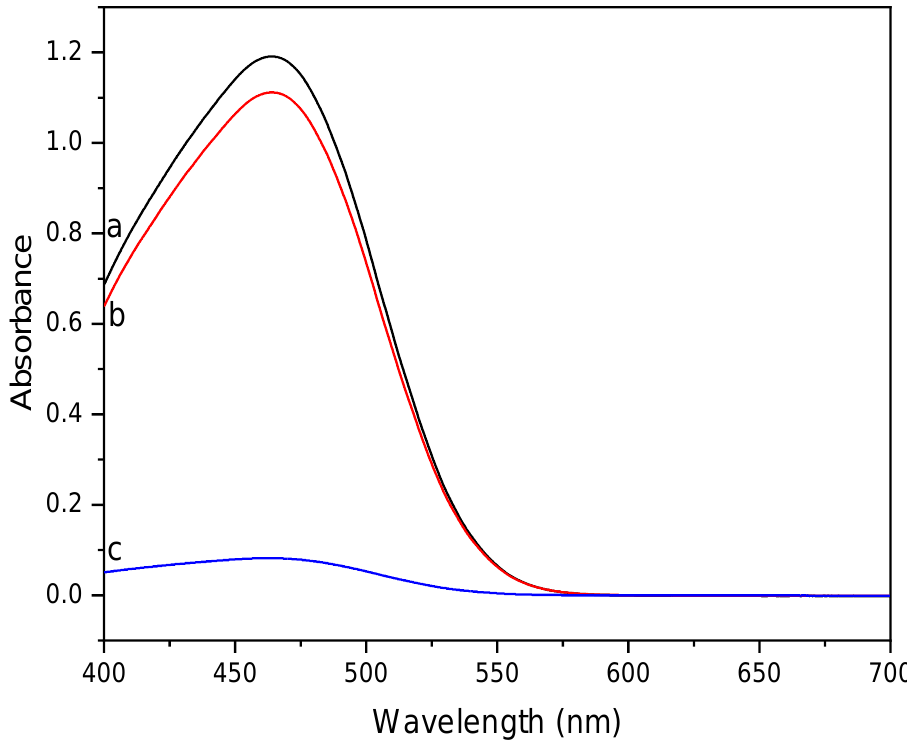
Figure 6. Experiment in the absence of light for a methyl orange solution (50 mg/L) at 0 min ( a ), and after 30 min for Cu 2 (OH) 3 NO 3 ( b ) and Cu 2 (OH) 3 (CH 3 COO) ( c ). These results show that for Cu 2 (OH) 3 (OCOCH 3 ), the observed values were due to adsorptive/photocatalytic process, while for Cu 2 (OH) 3 NO 3 , the observed values were due to only the photocatalytic process, without the influence of adsorptive